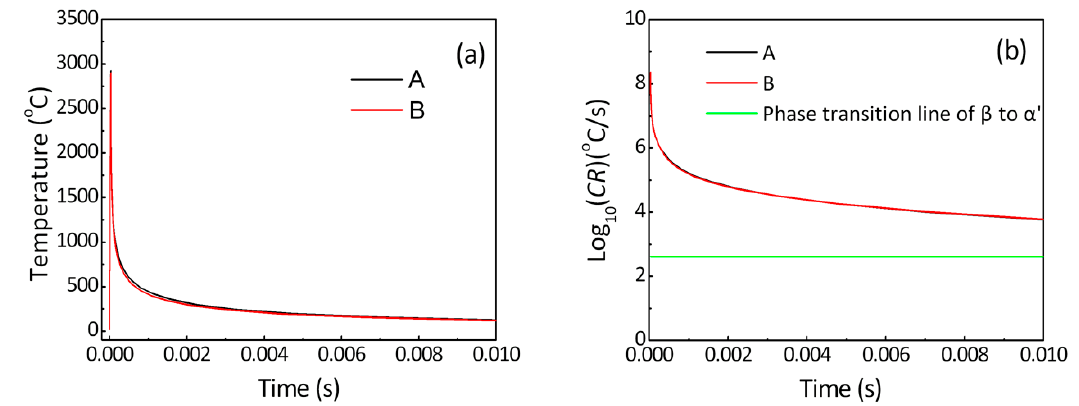
Figure 8. Temperature evolution ( a ); and cooling rate ( b ) of Points A and B shown in Figure 2.